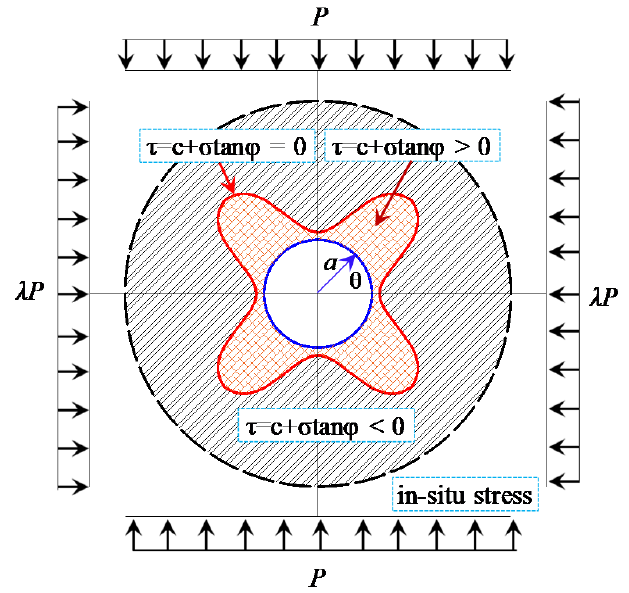
Figure 7. Mechanical model of the circular roadway.